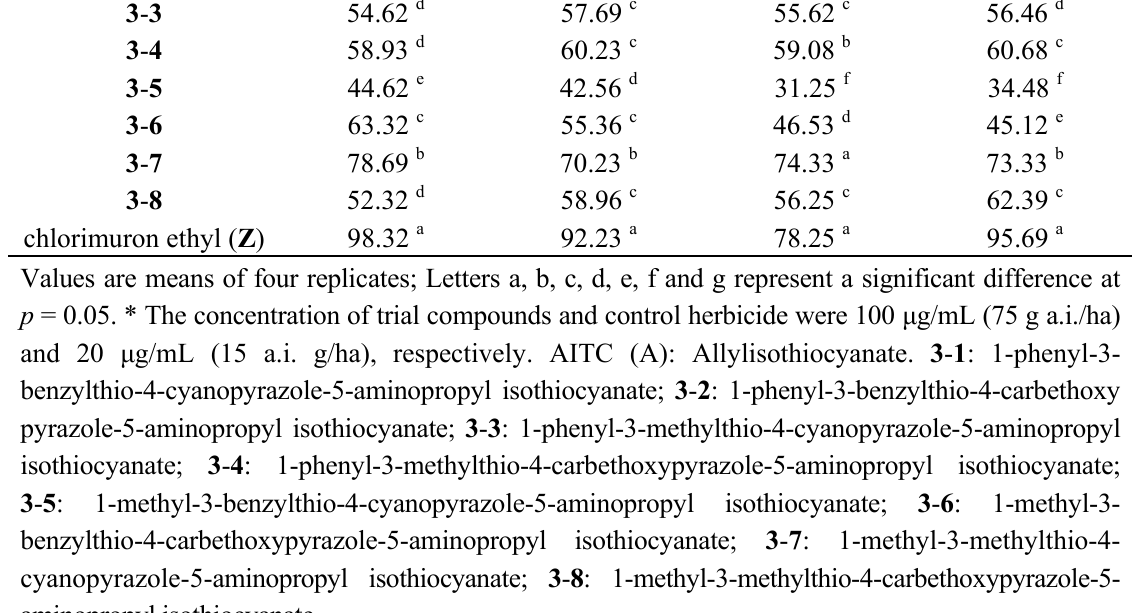
Table 1. Herbicidal activities of the samples against the four weeds *. Corrected strain efficacy (%) Compound Echinochloa Cyperus Dactylis Trifolium crusgalli L. iria L. glomerata L. repens L. 25.86 f 32.59 e 40.12 e 13.33 g 79.39 b 86.53 a 79.26 a 75.57 b 65.32 c 68.59 b 64.53 b 65.78 c 54.62 d 57.69 c 55.62 c 56.46 d 58.93 d 60.23 c 59.08 b 60.68 c 44.62 e 42.56 d 31.25 f 34.48 f 63.32 c 55.36 c 46.53 d 45.12 e 78.69 b 70.23 b 74.33 a 73.33 b 3 - 8 52.32 d 58.96 c 56.25 c 62.39 c chlorimuron ethyl ( Z ) 98.32 a 92.23 a 78.25 a 95.69